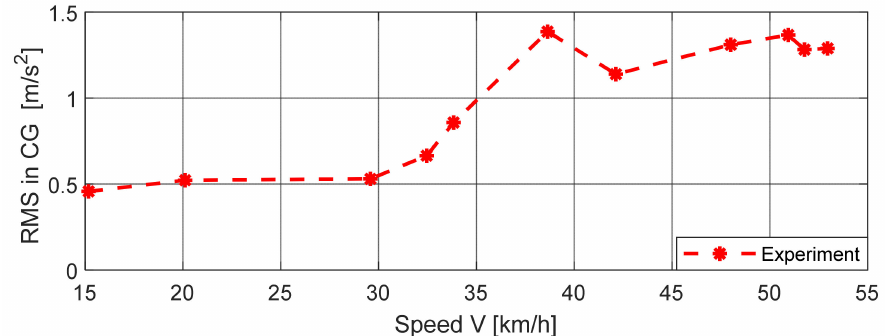
Figure 41. RMS of acceleration in vehicle CG versus speed V.